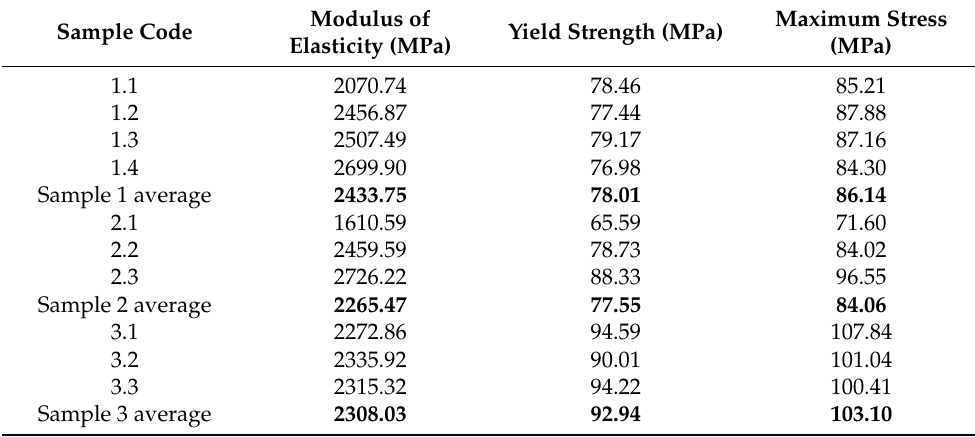
Table 4. The compression test results for the bone cement samples.